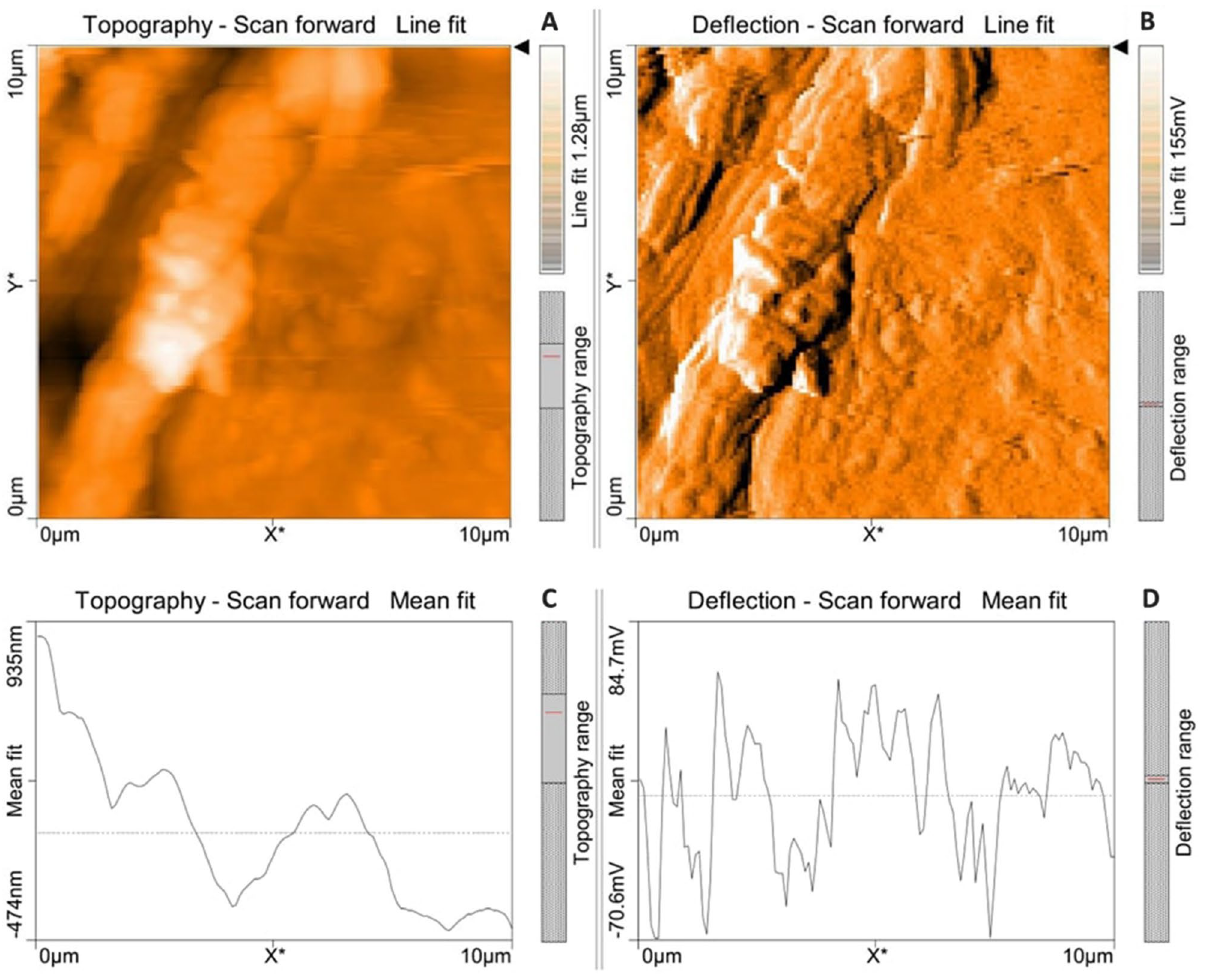
Figure 21. Atomic force microscopic results of microalga U. africanum treated LDPE sheet of 10 µm 2 area: ( A ) Topography of the surface (Line fit); ( B ) Voltage deflection (Line fit); ( C ) Topography with mean fit; and ( D ) Voltage deflection with mean